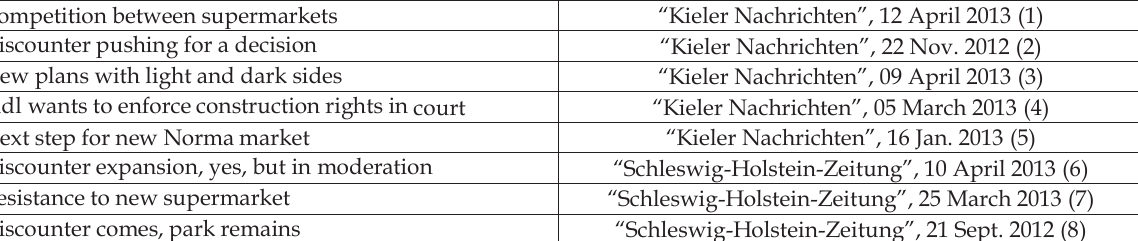
Table 3. Grocery discounters in local news.